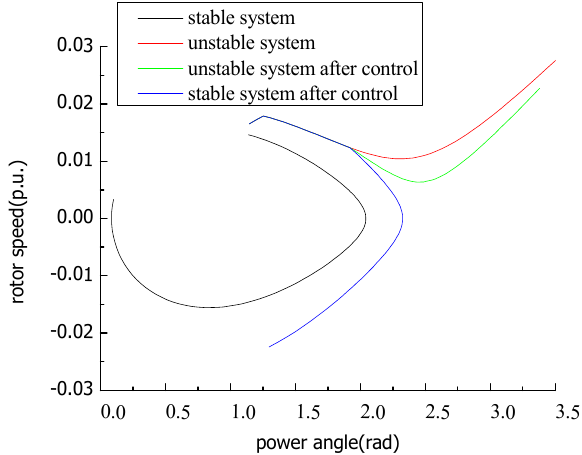
Figure 4. State ‐ plane representation of speed and angle.